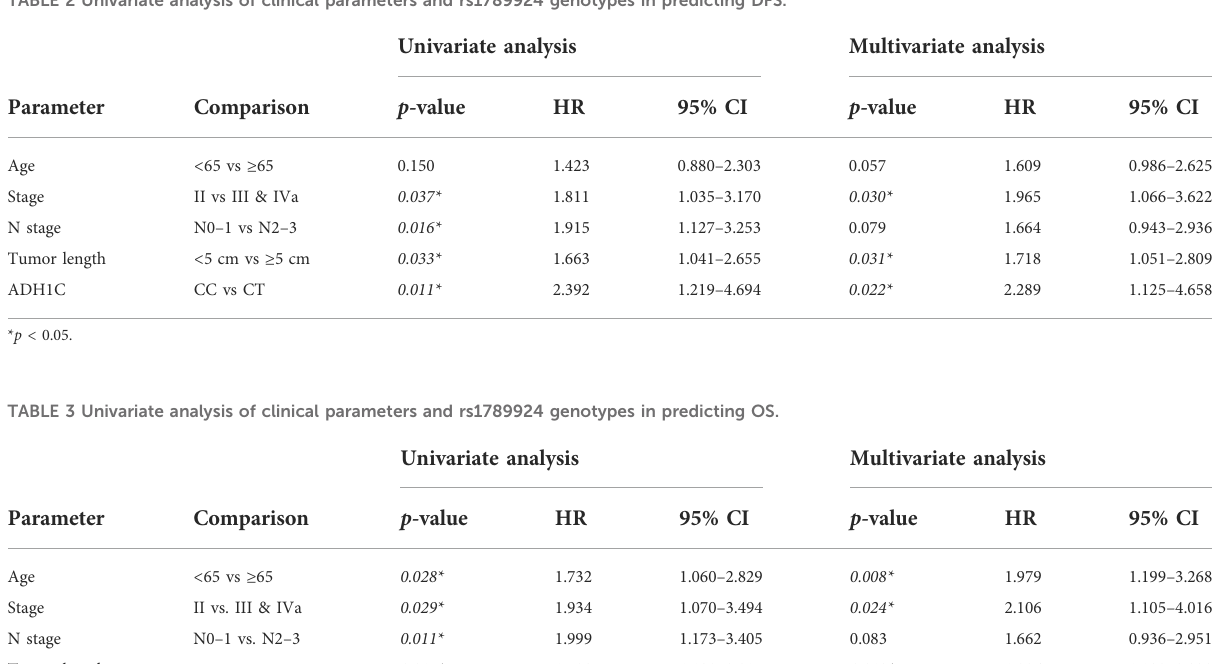
TABLE 2 Univariate analysis of clinical parameters and rs1789924 genotypes in predicting DFS.